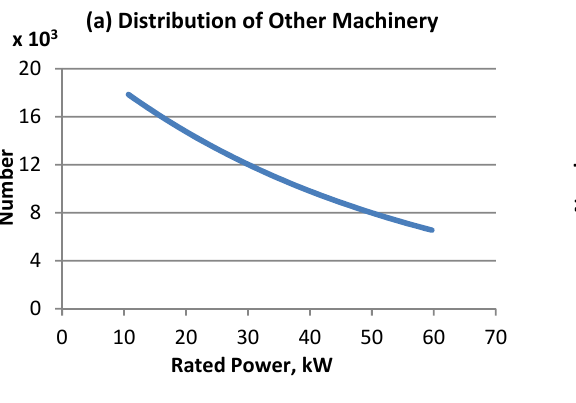
Figure 2. Distribution curves of the agricultural machinery with rated